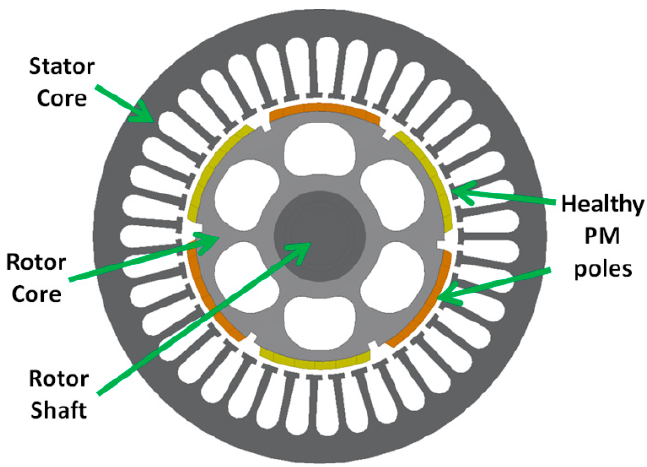
Figure 1. Cross-sectional view of the Permanent Magnet Synchronous Machine (PMSM) geometry.